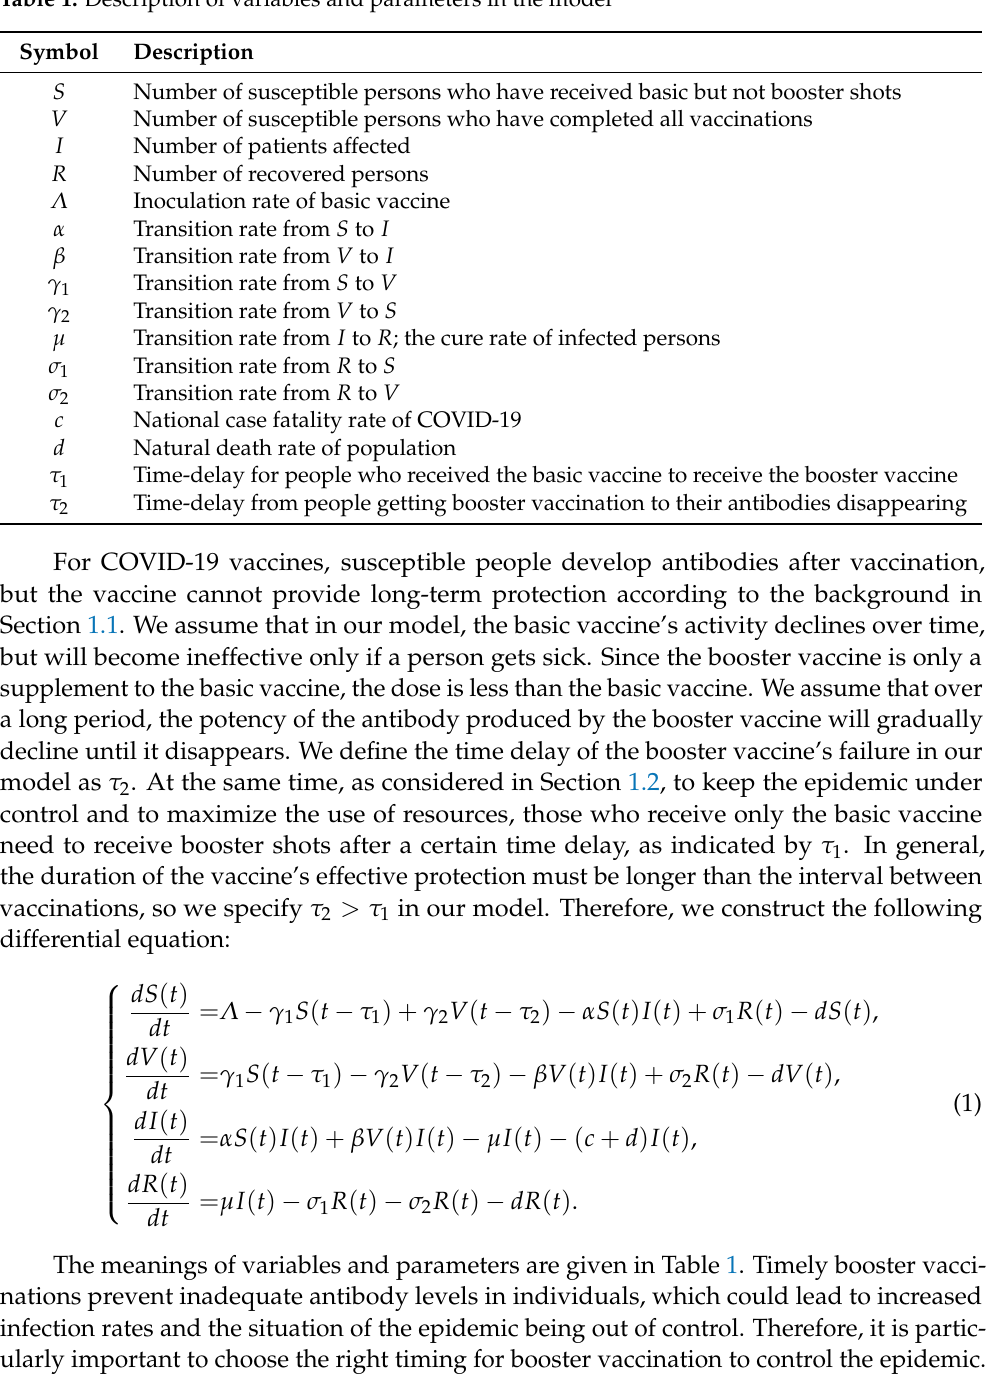
Table 1. Description of variables and parameters in the